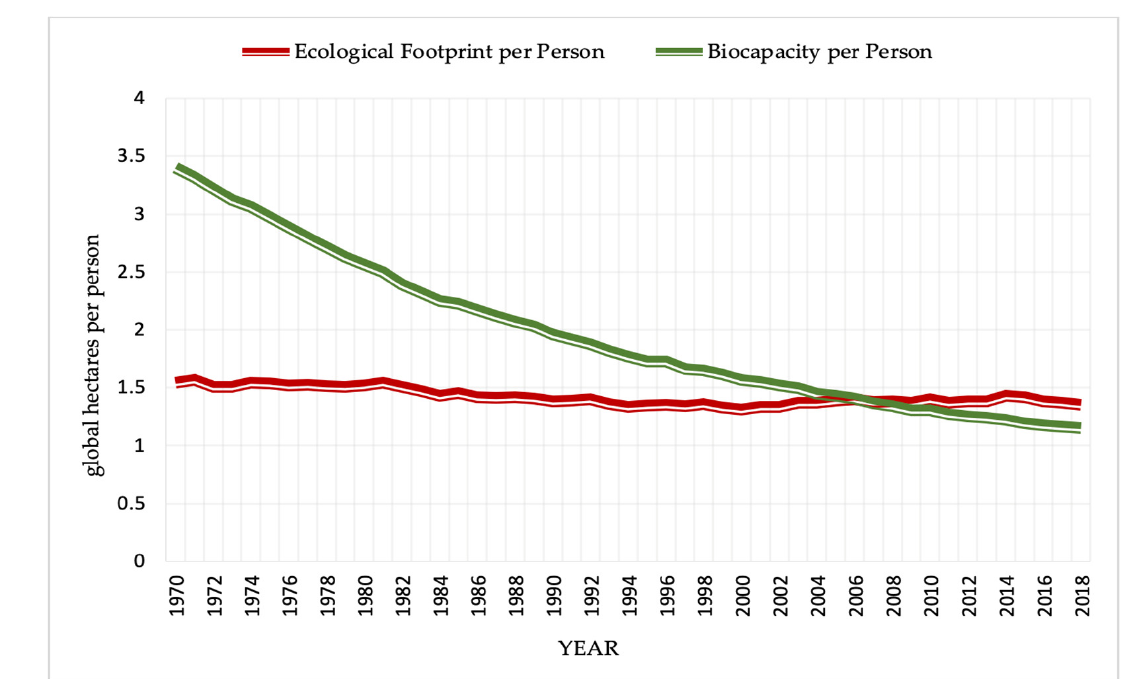
Figure 1. Africa’s ecological footprint and biocapacity per person from 1990 to 2018.